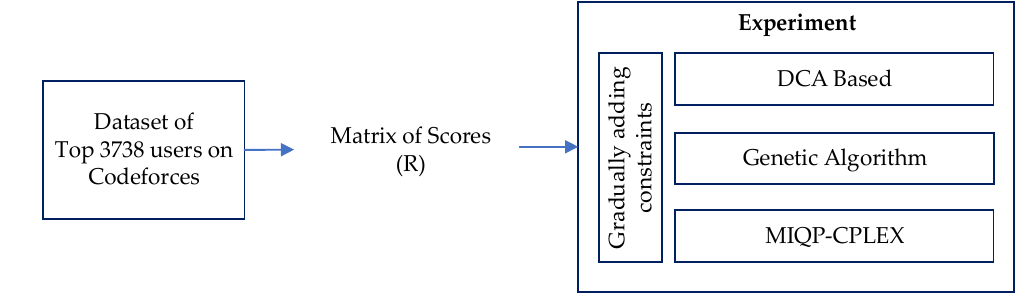
Figure 8. The procedure of the experiment.